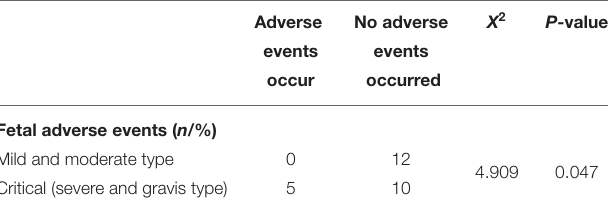
HFRS, Hemorrhagic fever with renal